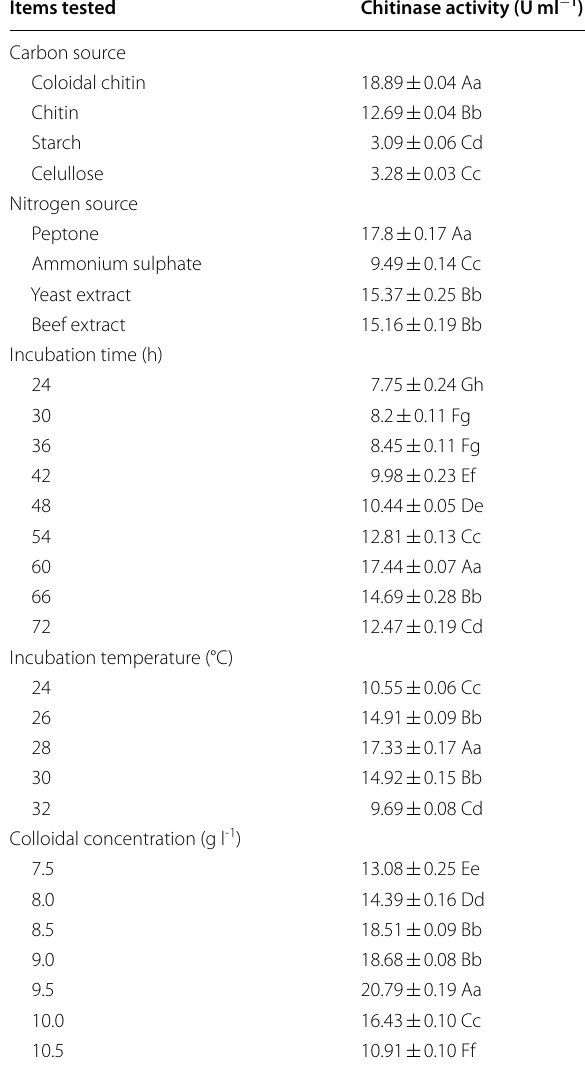
Table 4 Effects of culture conditions on chitinase production by strain TC‑1